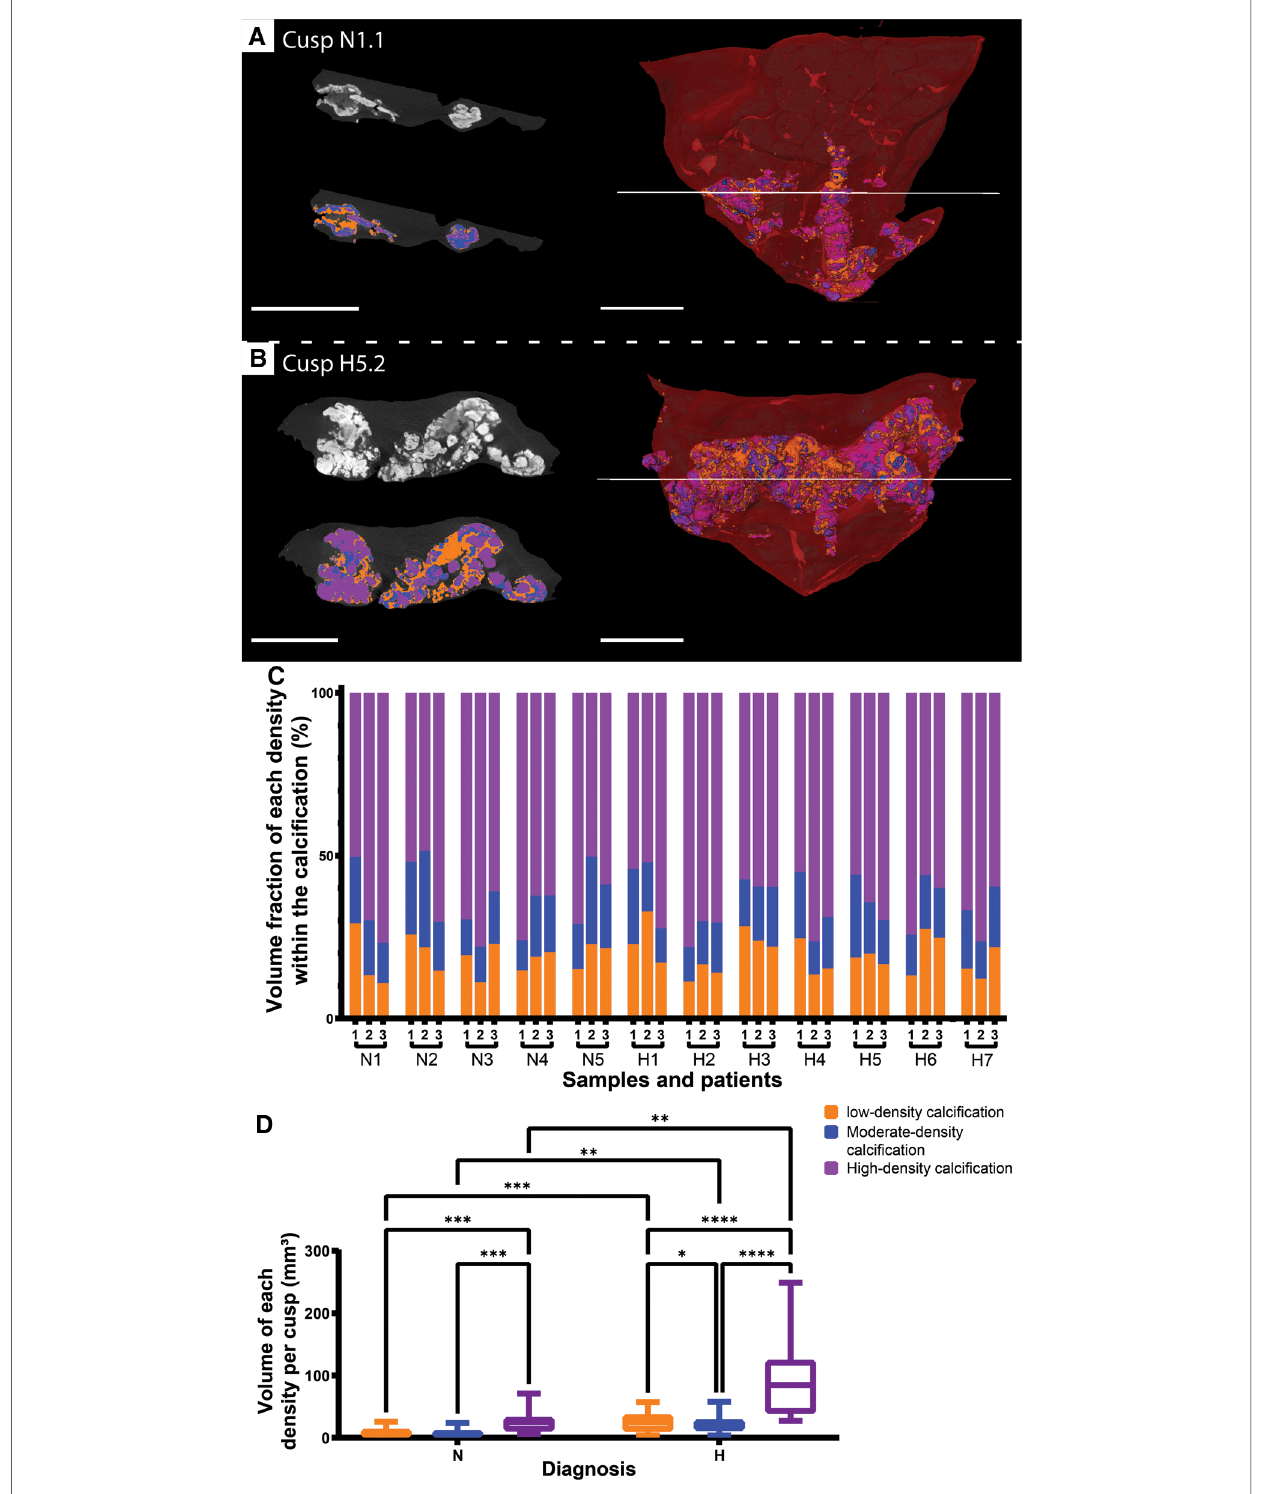
FIGURE 3 Distinction of three levels of density within the calci fi cations. ( A,B ) Ortho-slices in gray scale (top left) and after segmentation (bottom left) and 3D renderings (right) for cusp N1.1 ( A ) and cusp H5.2 ( B ). Low-density is shown in orange, moderate-density is shown in blue and high-density is shown in purple. Soft tissue is shown in dark gray on ortho-slices and in red on 3D renderings. Scale bars=5 mm. ( C ) Volume fraction of each density group within the calci fi cation for every cusp. ( D ) Box plots comparing the impact of the diagnosis within a density group, as well as of the density within a diagnosis group on the absolute volume of each density group. *: p -value<0.05, **: p -value<0.01, ***: p -value<0.001, ****: p -value<0.0001, N, NF-LG-SAS; H,